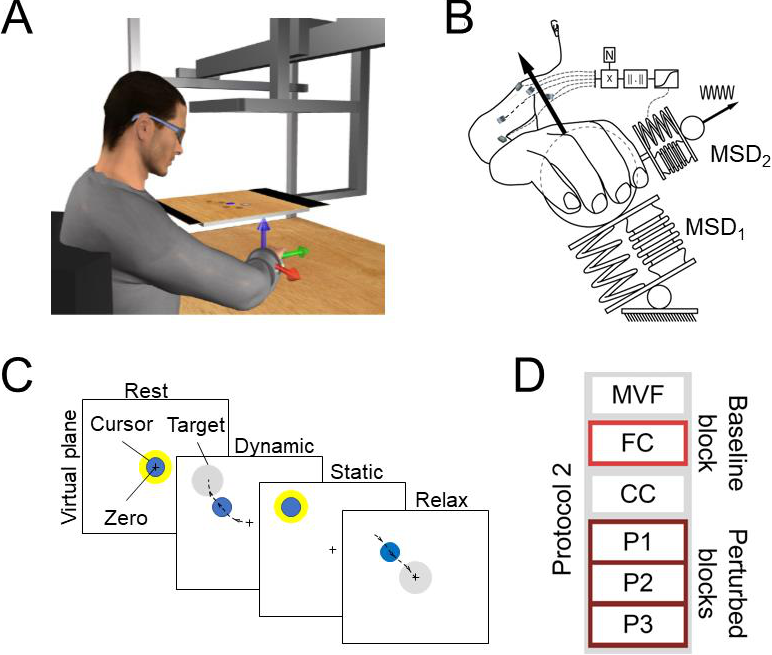
Figure 6. Experimental setup and protocol. ( A ) Setup. The reference system origin was centered in the participant’s palm. Arrows with different colors indicate the reference system axes (red: x-axis; green: y-axis; blue: z-axis). ( B ) Concept of the Perturbed blocks (P1, P2, and P3) of Protocol 2. The position of a virtual cursor was modeled as two connected mass-spring-damper systems. Participants controlled the mean position of the cursor by exerting a force on the first virtual mass-spring-damper system (MSD1) and controlled the cursor’s oscillation around the mean position by modulating the stiffness of a second virtual mass-spring-damper system (MSD2), which was perturbed by a constant sinusoidal force, through its level of co-contraction. The co-contraction was calculated as the norm of the projection of the instantaneous muscle activation along the null-space component of the EMG-to-force matrix, as calculated during the FC block. ( C ) Task. ( D ) The six blocks of which the protocol was composed were an initial MVF block, a baseline force control block (FC), a pure co-contraction block (CC), and three perturbed blocks (P1, P2, and P3). However, in this study,